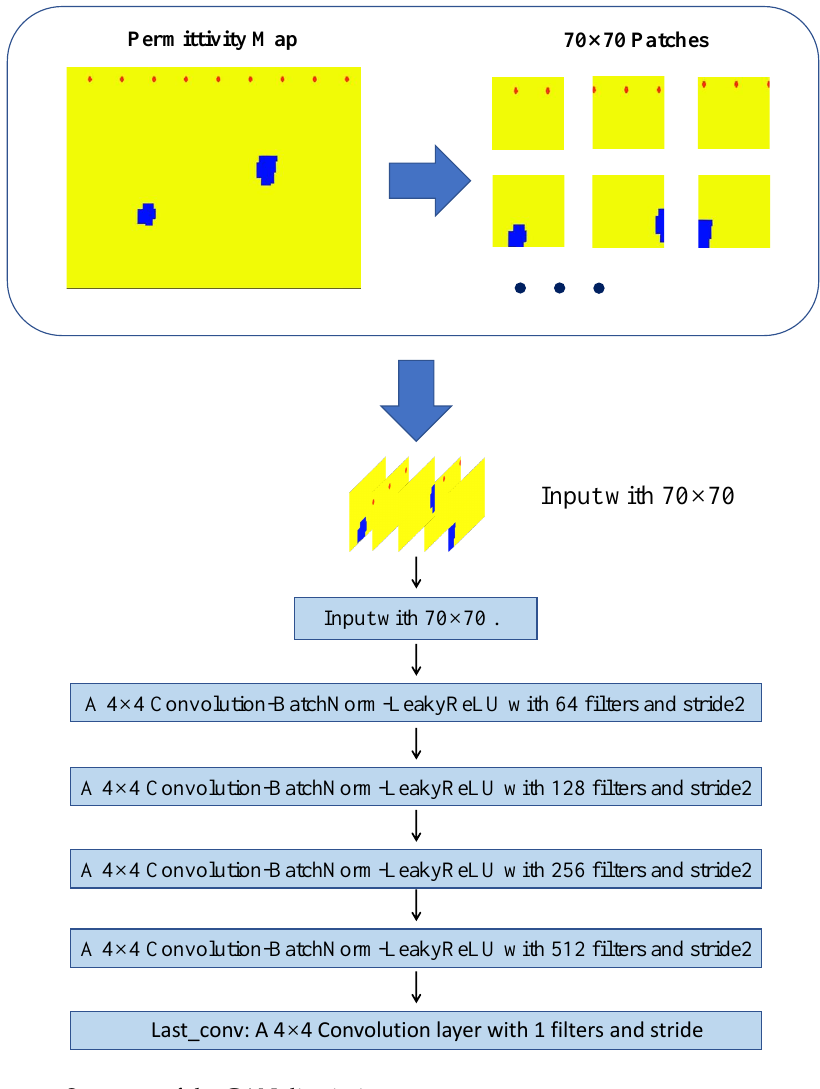
Figure 2. Structure of the GAN